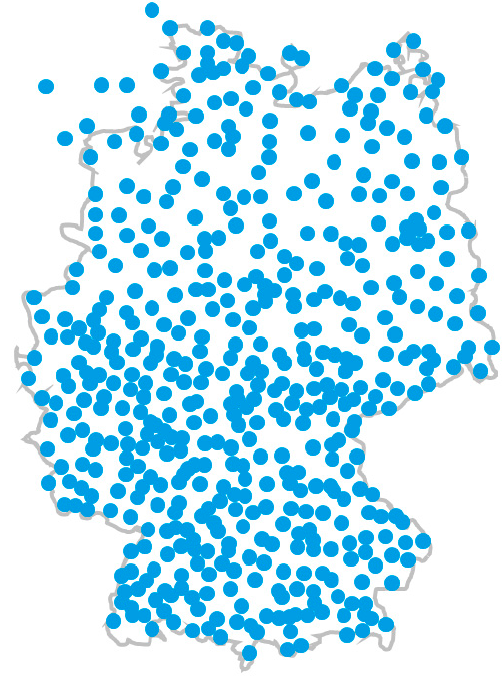
Figure 1. Availability of 537 weather stations in Germany (own representation).